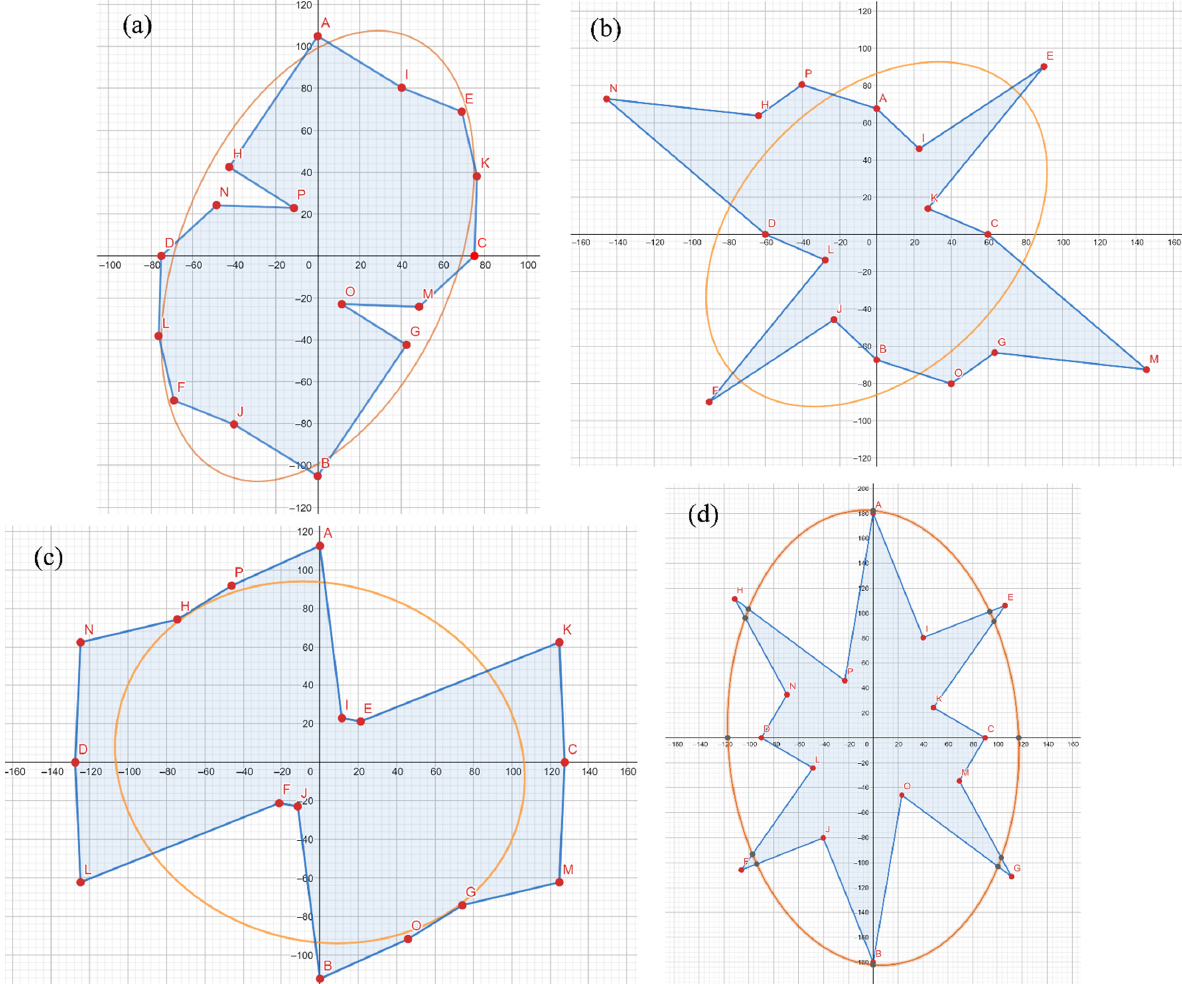
Figure 5. Two-dimensional ellipsoid anisotropy fitting using a direct least square method for coal deposit parameters: ( a ) ash content, ( b ) caloric value, ( c ) total sulfur, and ( d ) seam thickness (after [7]).